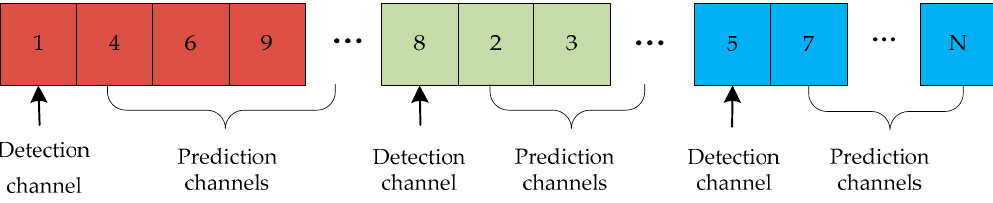
Figure 2. Wideband spectrum sensing method based on clustering and prediction.